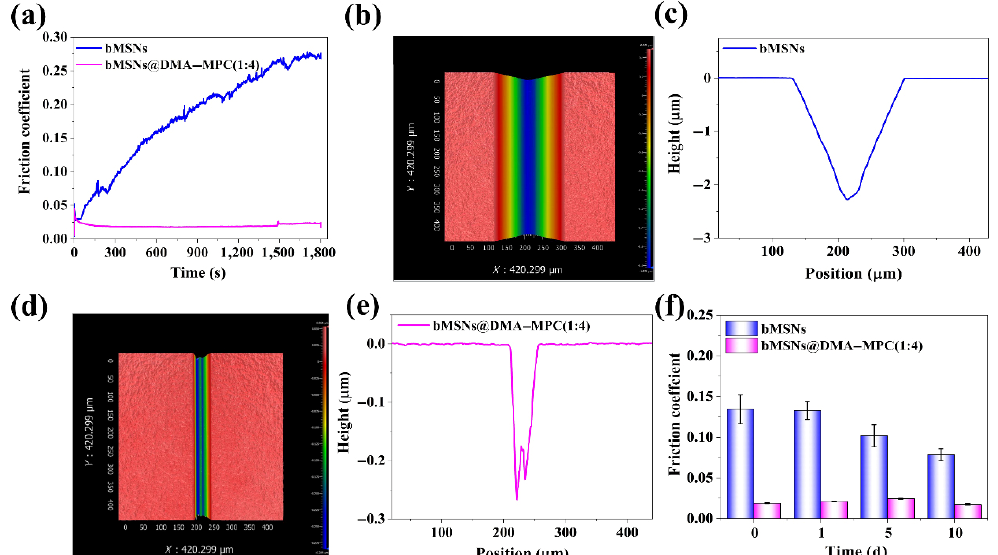
Fig. 6 Characterizations of the lubrication properties of the bMSNs and bMSNs@DMA–MPC nanoparticles with extended time duration and biodegradation test conditions. (a) COF–time plots of bMSNs and bMSNs@DMA–MPC at a concentration of 1 mg/mL, a contact stress of 22.1 MPa, a reciprocating frequency of 1 Hz, and a duration of 30 min. Surface morphologies of the wear zone on the Ti6Al4V surface and the corresponding surface profiles across the wear scratches for (b, c) bMSNs and (d, e) bMSNs@DMA–MPC nanoparticles. (f) COF values of the bMSNs and bMSNs@DMA–MPC nanoparticles incubated with SBF at different time intervals. Tribological test conditions are contact pressure: 22.1 MPa; concentration: 1 mg/mL; reciprocating frequency: 1 Hz; and time: 10